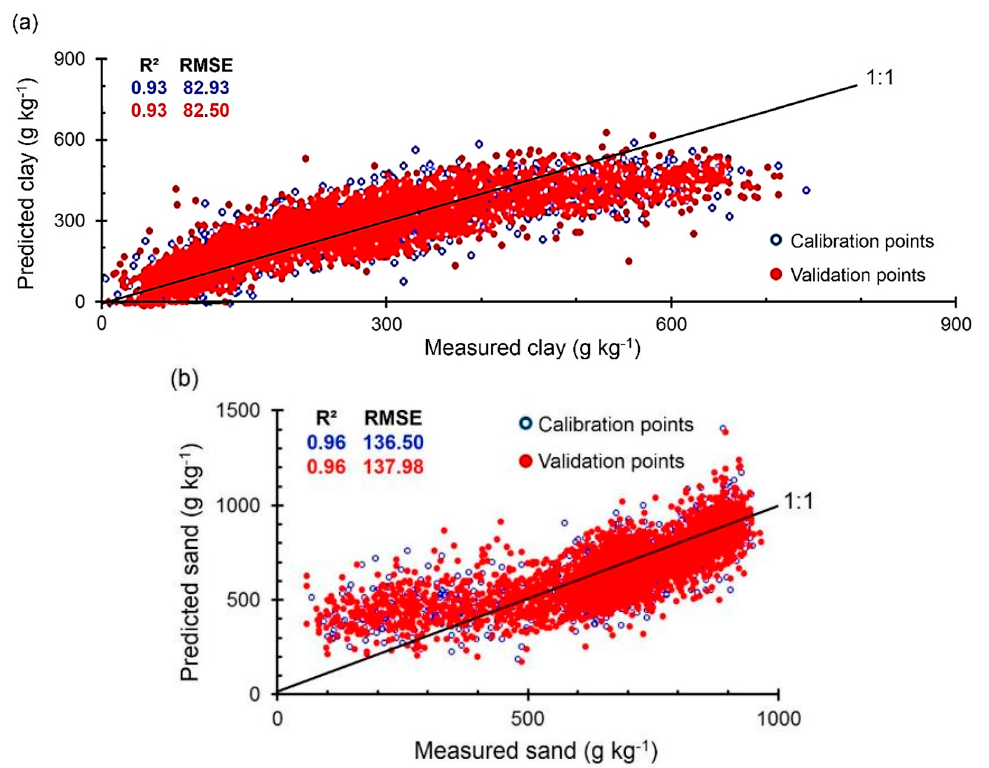
Figure 7. Regression results with Treatment 3: PLSR3, transformation of spectral reflectance data to absorbance, and generation of a prediction model for: clay ( a ); and sand ( b ).